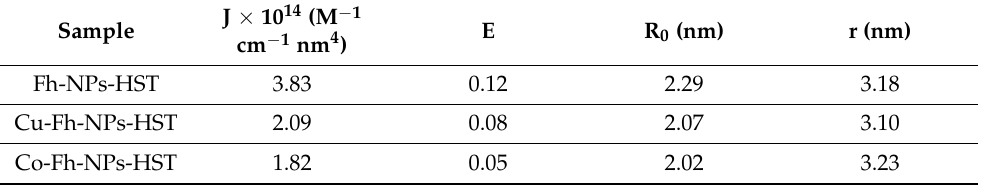
Table 3. FRET parameters for the interaction of simple and doped Fh-NPs with HST.